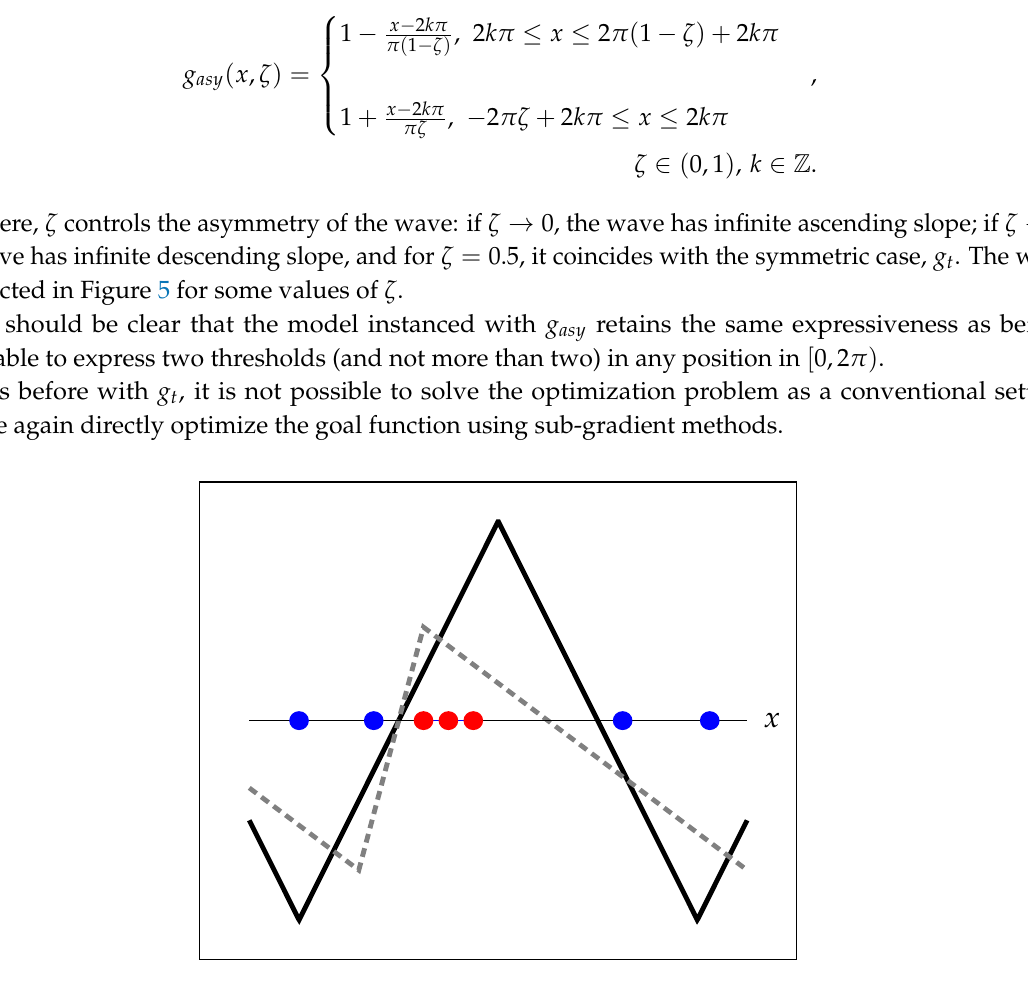
Figure 4. Toy example where the fitted symmetric model does not provide an appealing solution.